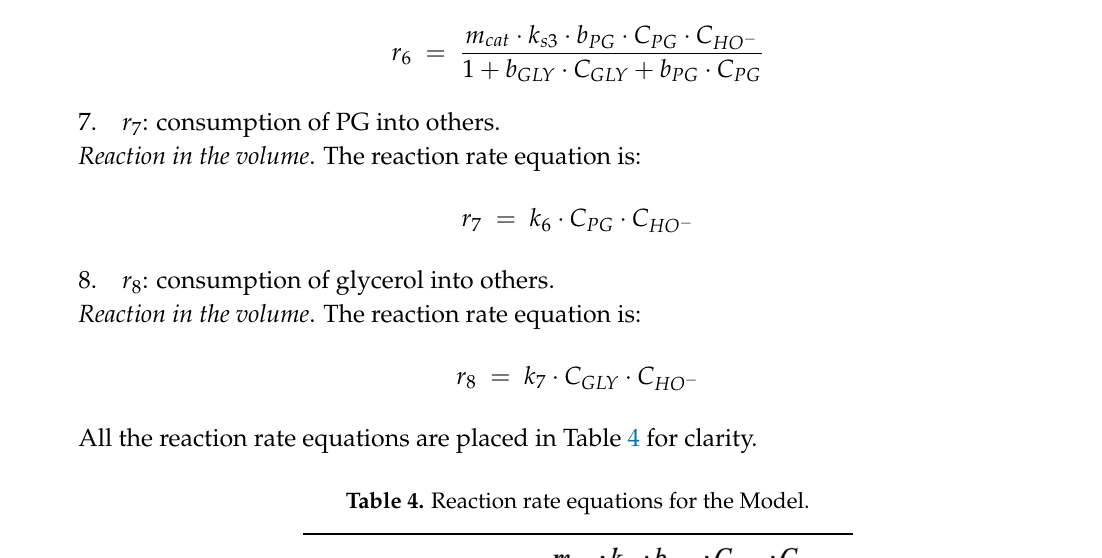
Table 4. Reaction rate equations for the Model.